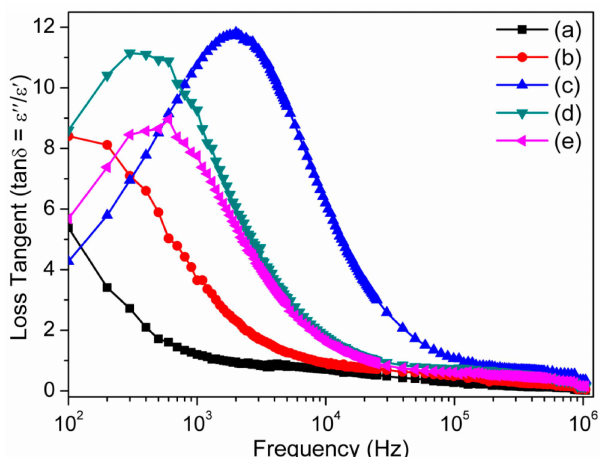
Figure 13. Frequency dependence dielectric loss tangent (tan δ ) of the unsintered pellets ( a ) at 25 ˝ C (black) and sintered ceramics pellets and those sintered at ( b ) 450 ˝ C (red) (S450); ( c ) 650 ˝ C (blue) (S650); ( d ) 850 ˝ C (olive green) (S850); and ( e ) 1050 ˝ C (pink)